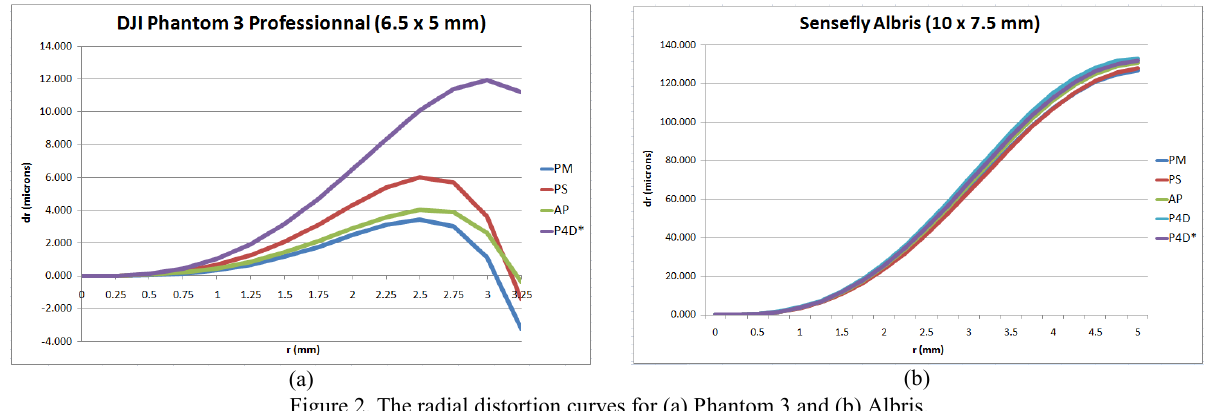
Figure 2. The radial distortion curves for (a) Phantom 3 and (b)